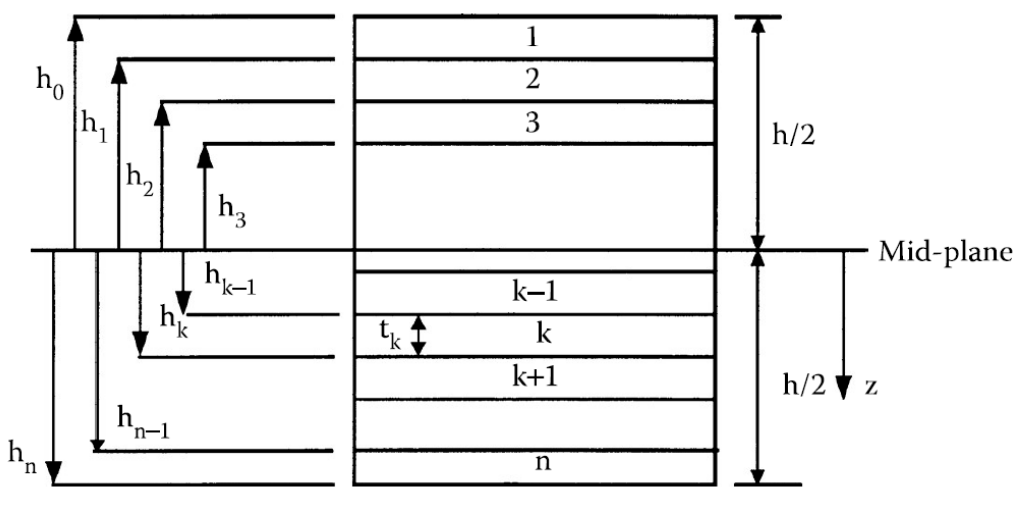
Figure 3. Location of plies in a laminate.